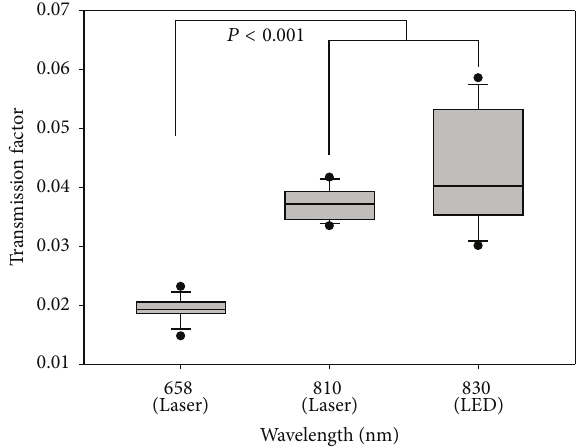
Figure 5: Transmission factor of red (658 nm) and 810 nm infrared laser light and of 830 nm infrared LED radiation. For further explanations, see Figure